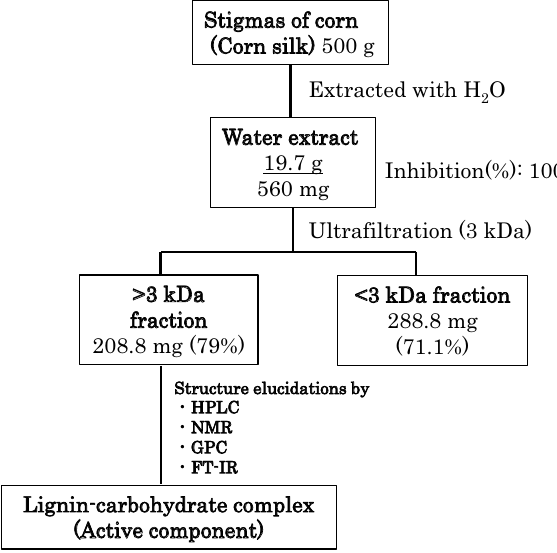
Figure 1. The overview of experimental procedure of this